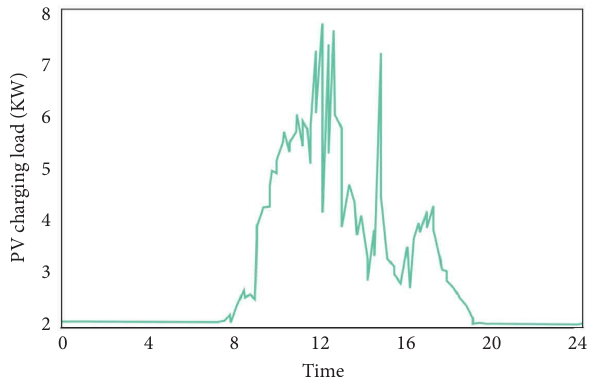
Figure 6: Te predicted value of hourly PV generation.